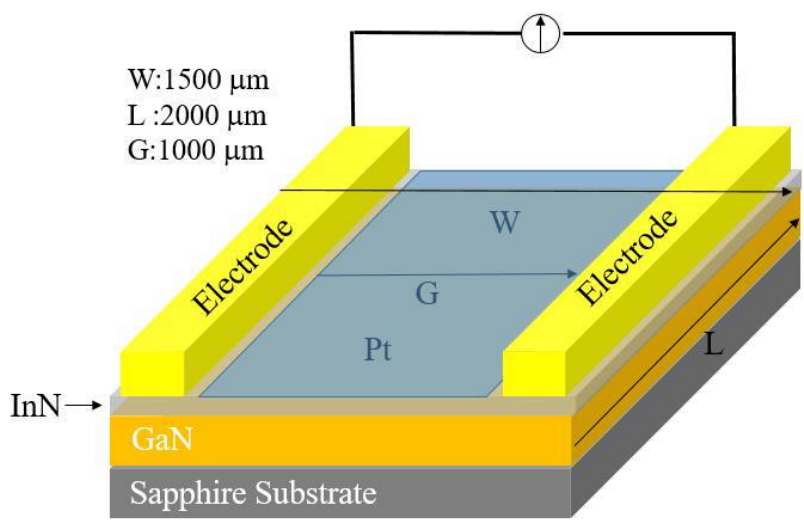
Figure 3. Schematic structure of the hydrogen sensor based on Mg-doped InN.